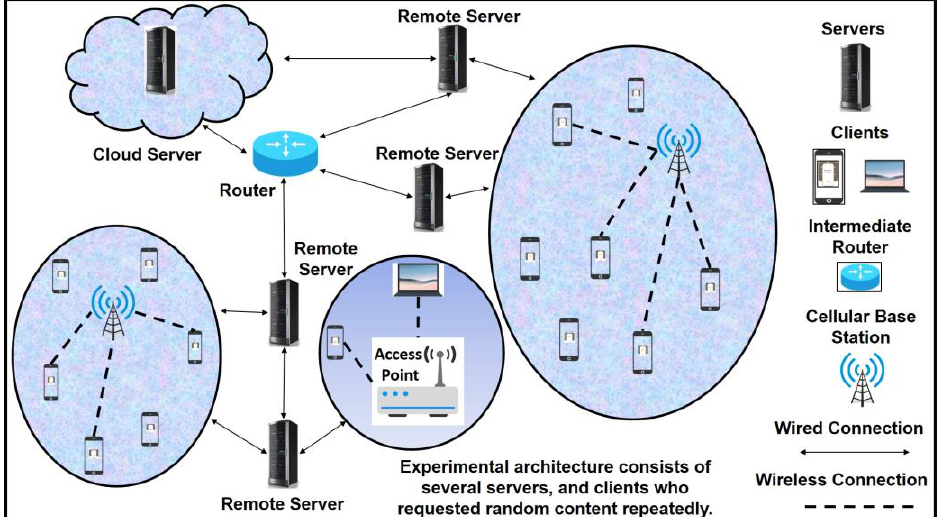
Figure 1. Depiction of one of the network